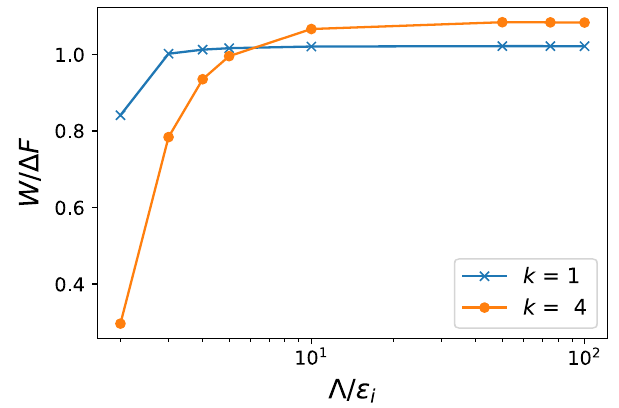
FIG. 15. Convergence of the work done over an entire protocol, τ weak k τ weak =k 2 , for various values of the where τ and τ on on on ¼ iso ¼ 2 ε 0 . 1 , βε 1 , cutoff Λ . Parameters are ε , g 2 0 = ε f ¼ i i ¼ i ¼ 2 . 5 , and g 2 τ weak g 2 0 τ weak ¼ 50 0 on ¼ iso